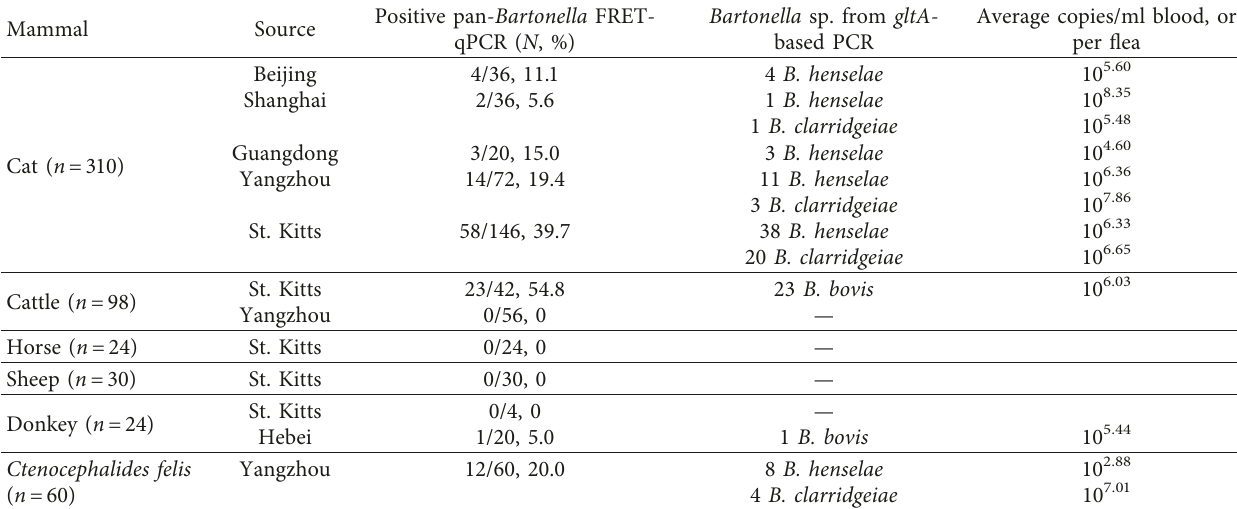
Figure 3: Molecular phylogenetic analysis of Bartonella spp. in this study. Distances and groupings of Bartonella spp. detected in this study (bold font) and reference Bartonella sequences from NCBI were determined by the maximum likelihood and Bayesian inference method with the MEGA version 6 software based on the gltA gene (439 bp). Bootstrap values were calculated using 500 replicates. Scale bar indicates a genetic distance of 0.02nt substitutions per position. Table 1: Molecular prevalence of Bartonella in